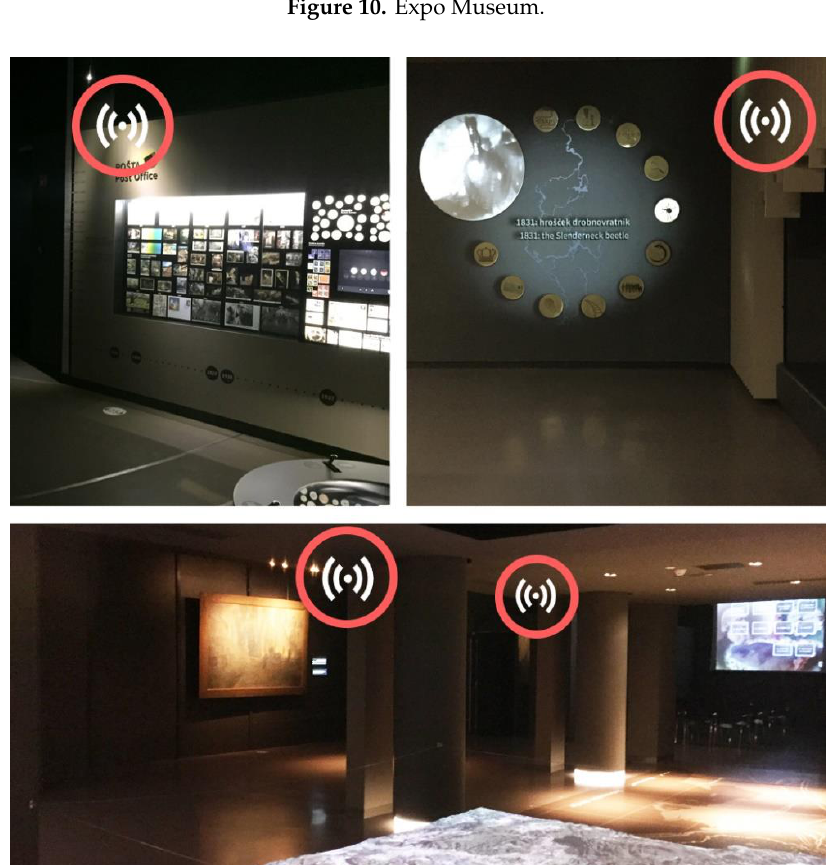
Figure 11. The locations of smart beacons in the Expo museum.